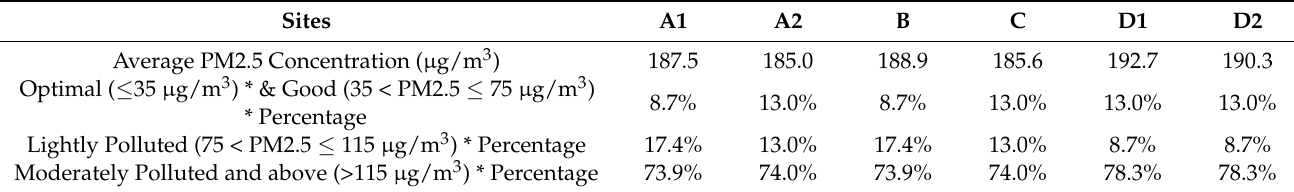
Table 2. PM2.5 concentrations across research